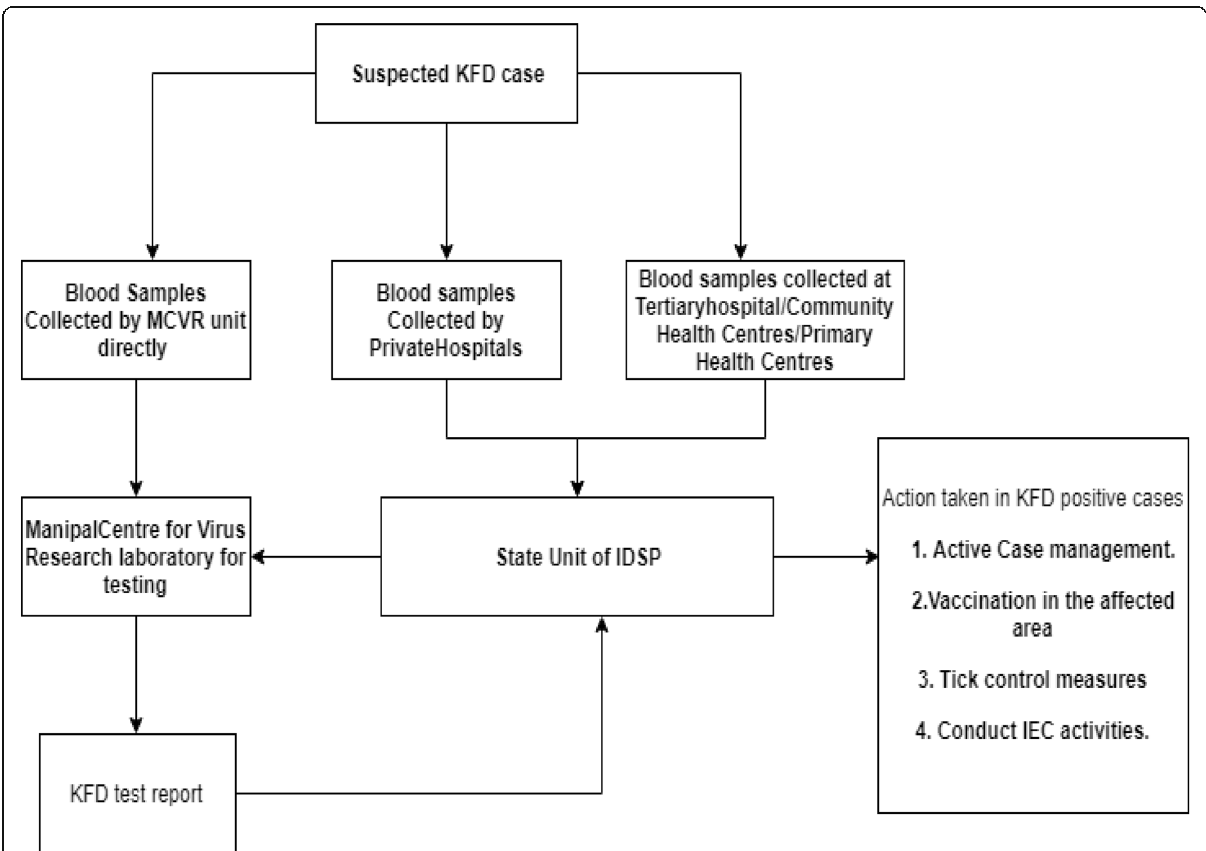
Fig. 2 Flow chart showing diagnosis and management of suspected cases of Kyasanur Forest Disease in the state of Goa, India, during 2015 –